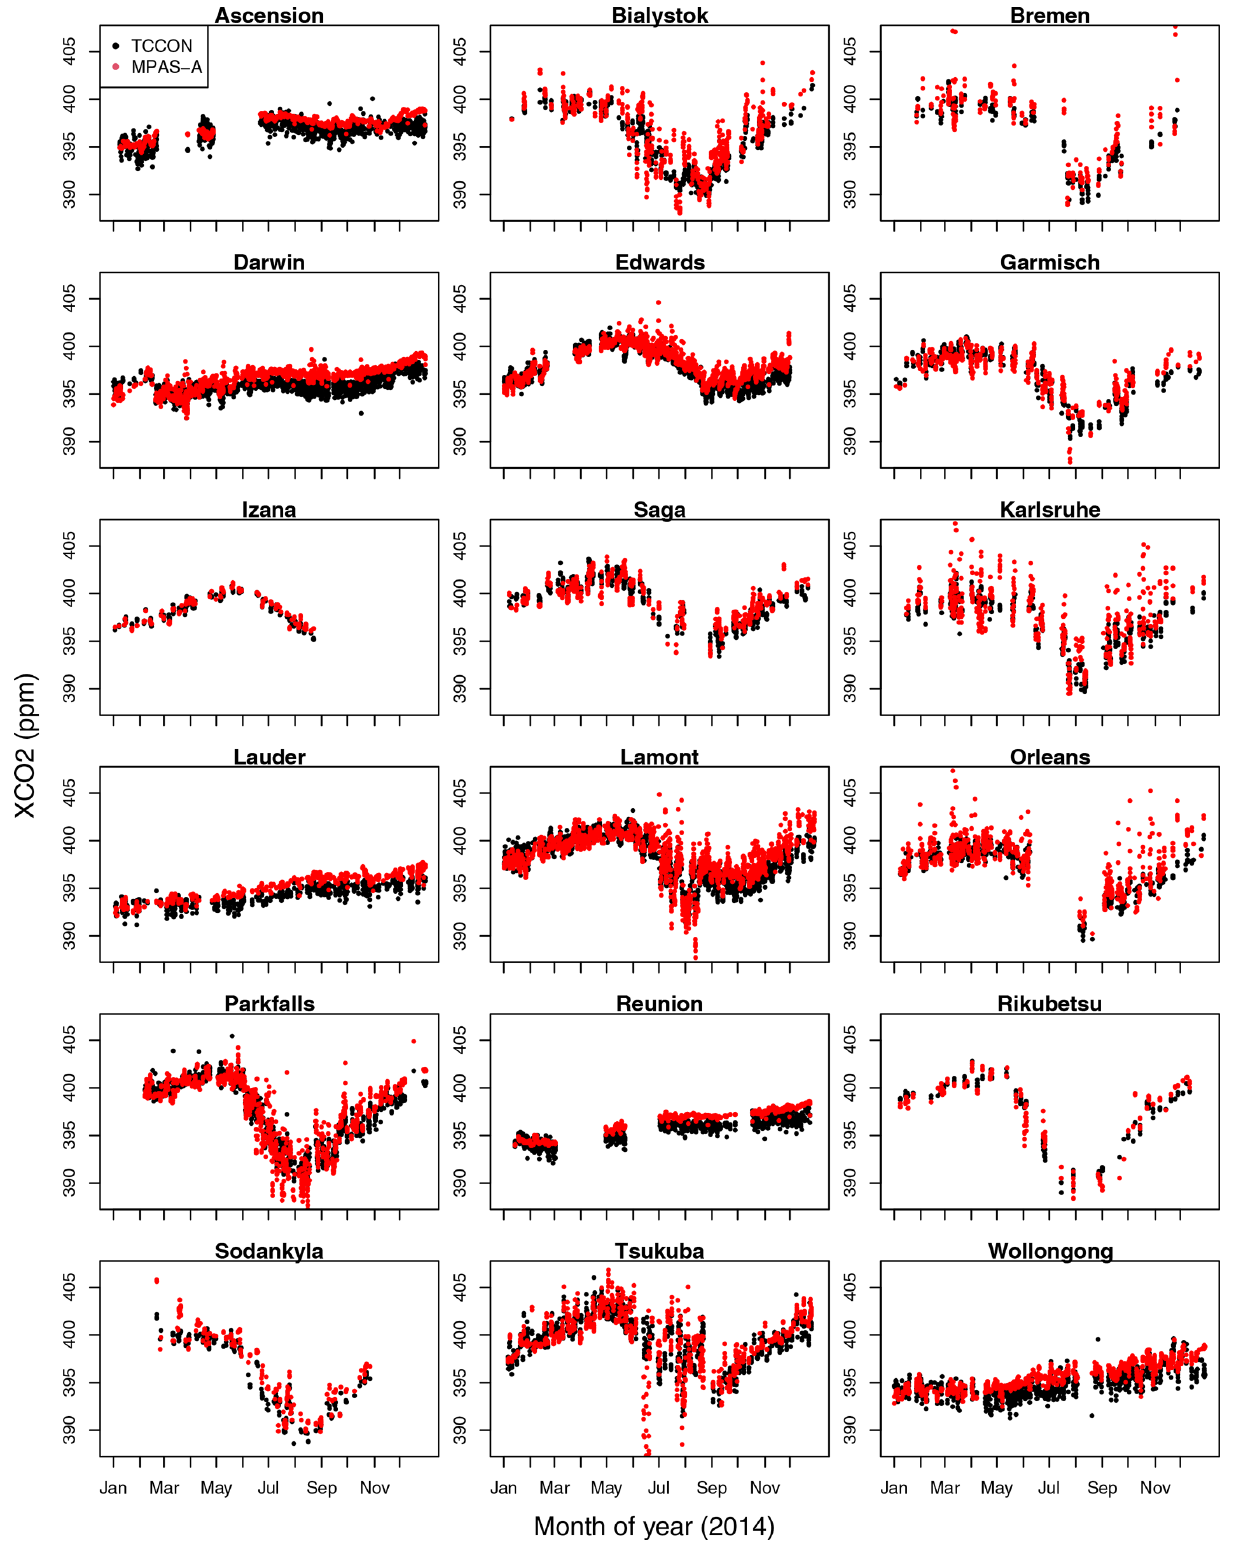
Figure 7. Simulated hourly XCO 2 of MPAS-A at 18 TCCON sites for the year 2014.